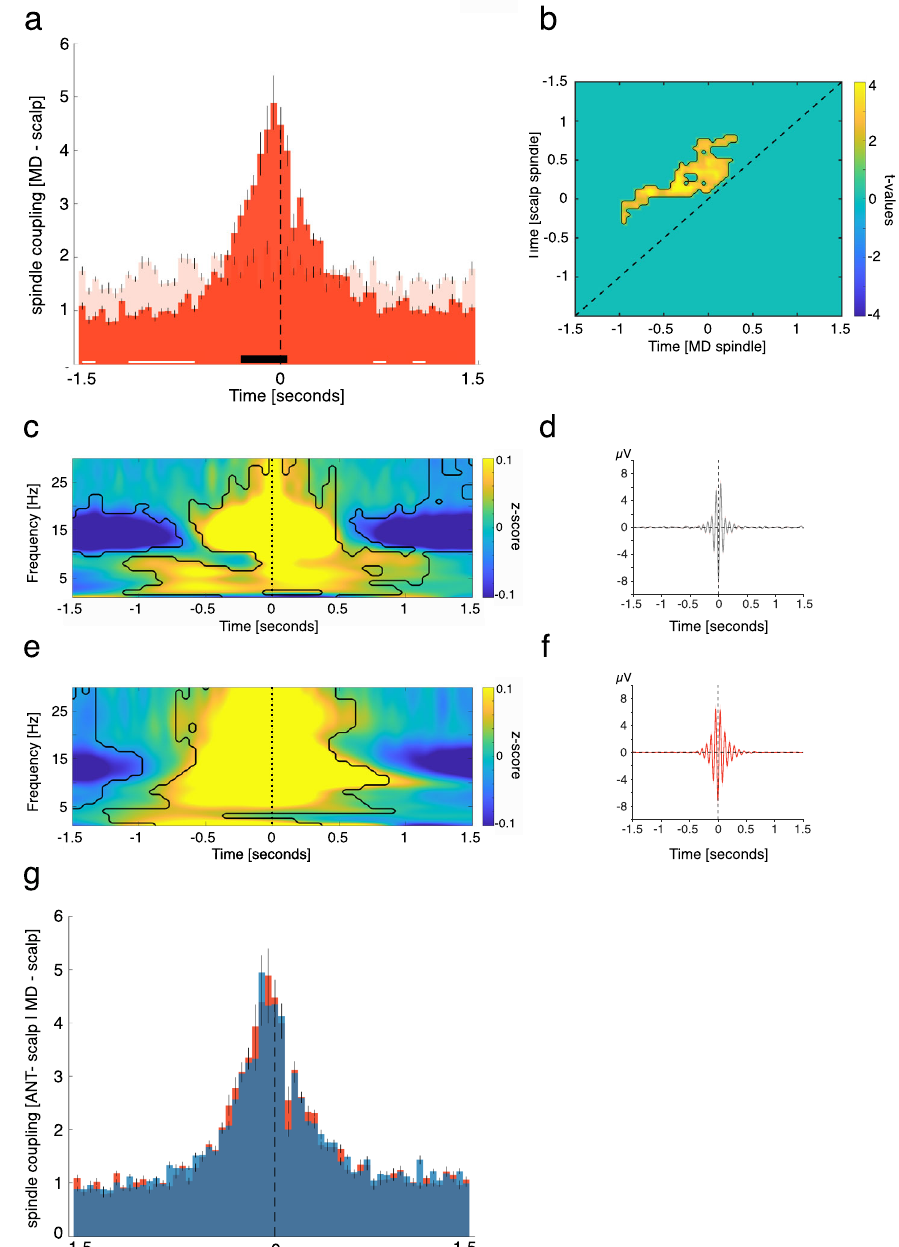
Fig. 5 | MD spindles lead neocortical spindles. a Occurrence probabilities of MD spindle peaks relative to neocortical spindle peaks (maximal negative amplitude, time = 0; dashed line; bin size = 50ms), indicating that MD spindles precede neo- cortical spindles. The solid black line indicates signi fi cant differences, resulting from comparison with spindle-free control events (dependent-samples t -test, two- sided, positive cluster from − 0.3 to 0.05s, p <0.005; time of peak: − 0.05 s; corrected for multiple comparisons across time). b Power – power correlations in the sleep spindle band for paired spindle events (locked to neocortical spindle peaks), contrasted against event-free correlation maps. The contour lines indicate the cluster (dependent-samples t -test, two-sided, p =0.002, cluster corrected across time),showing thatMD-related spindle power precedes neocortical spindle power. c Time – frequency representation of neocortical spindles (locked to neo- cortical spindle peaks), contrasted against event-free segments. The contour lines